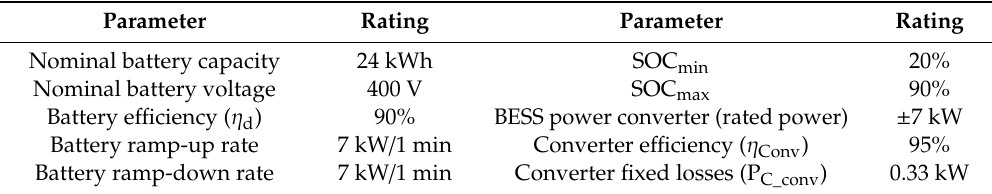
Table A2. Parameters of the battery energy storage system